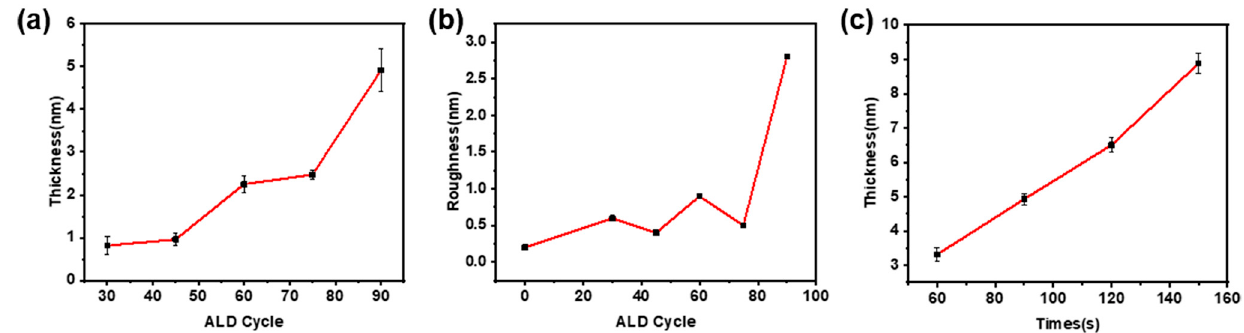
Figure 3. ( a ) The relationship between MoS 2 thickness and ALD cycle number; ( b ) The relationship between surface roughness of MoS 2 film and ALD cycle; ( c ) The relationship between C 60 thickness and hot evaporation time.